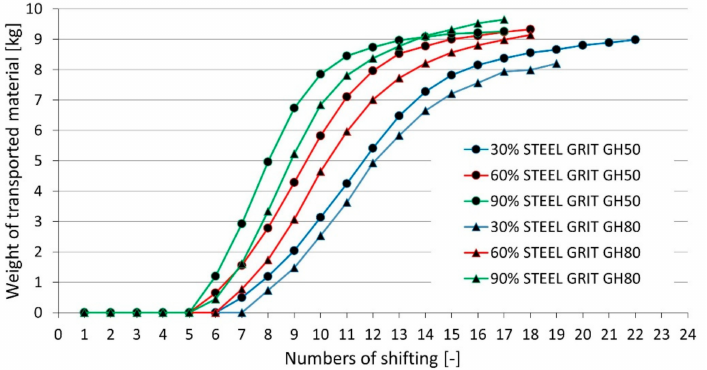
Figure 9. Dependence of real weight of the transported materials, STEEL GRIT GH50 and GH80, on number of the strokes during gradual feeding with 10 kg of this material at the 30%, 60% and 90% levels of shifting speed.